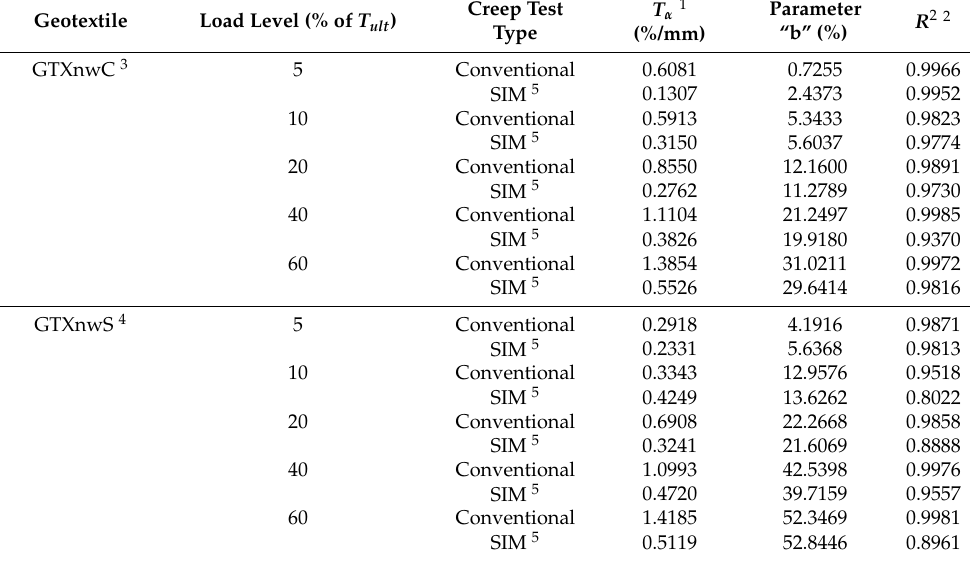
Table 2. Values of creep strain rate, parameter “b” and coefficients of determination of the best- fit regression lines that represent the geotextiles’ mean creep behaviour for the conventional and accelerated creep tests performed at each load level